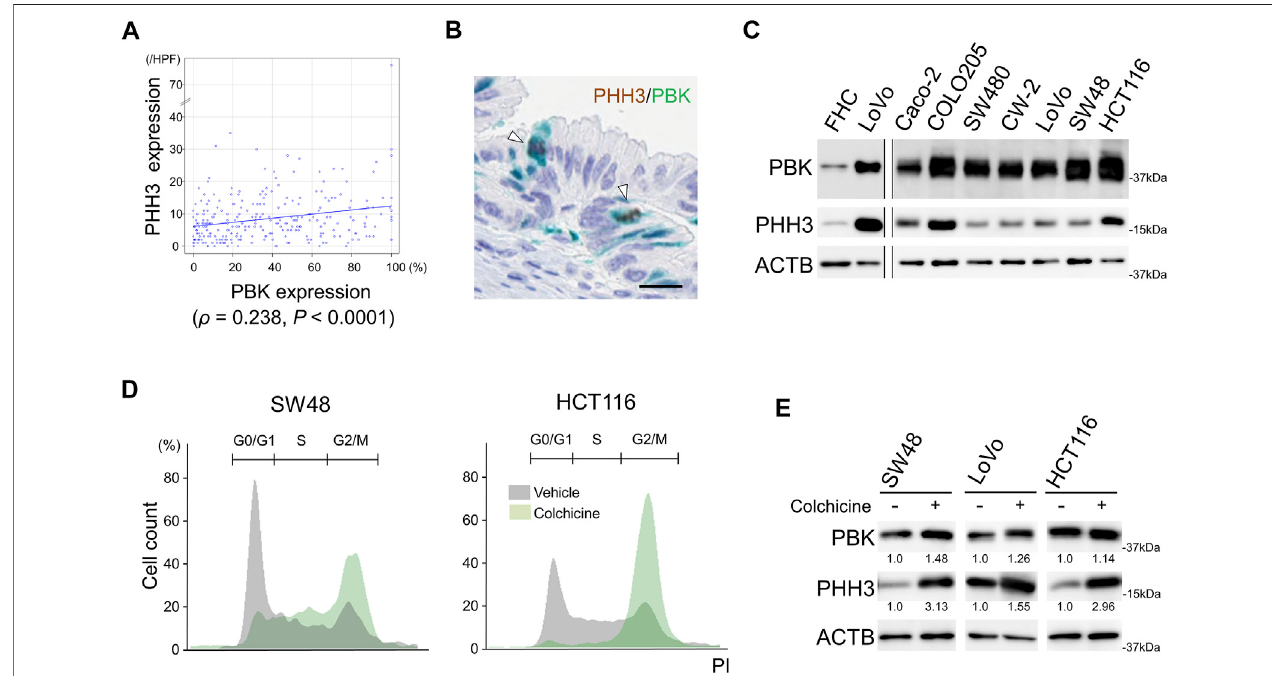
FIGURE1| CorrelationofPBKwithPHH3inCRCcells. (A) ,immunohistochemicalanalysisshowingtheassociationofPBKandPHH3expressioninFFPEsamples of269CRCs. (B) ,co-expressionofPBKandPHH3intheCRCsduringMphase.Bar (cid:2) 20 μ m (C) ,immunoblotanalysisshowingtheco-expressionofPBKandPHH3in FHC, a normal colonic epithelial cell line, and seven CRC cell lines. (D) , cell cycle analysis after colchicine treatment in SW48 and HCT116 cell lines and (E) , protein expression of PBK and PHH3 in CRC cells after colchicine treatment. Numbers below the immunoblot bands indicate relative expression.